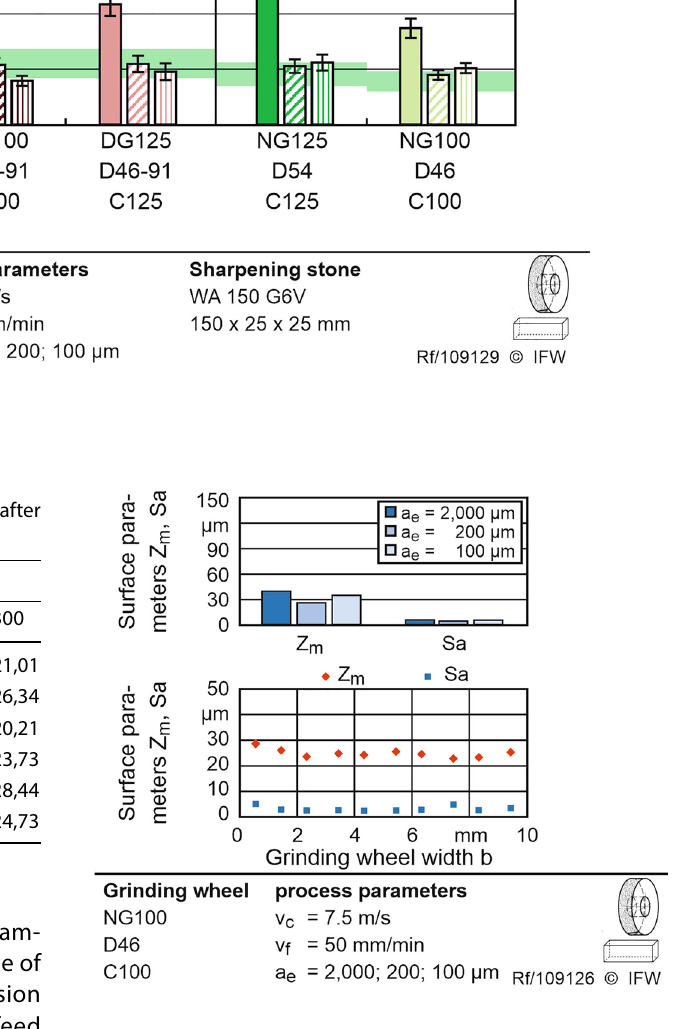
Fig. 5 Influence of sharpening on Z wheel